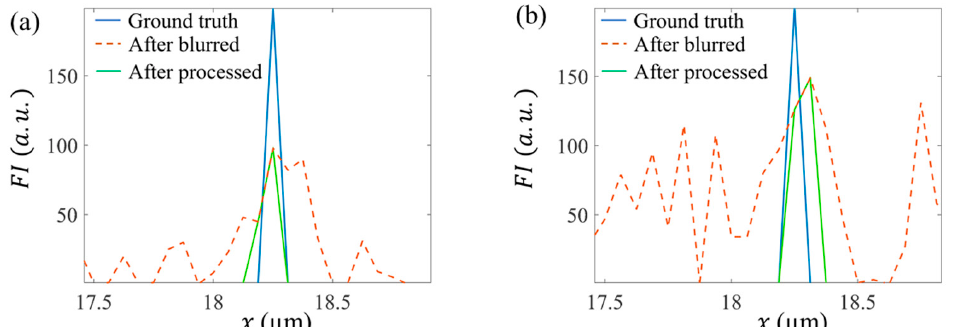
Figure 7. Comparison between the profiles in the ground truth image, blurred and noised image, and DWDC processed images; ( a ) corresponds to Figure 5, and ( b ) corresponds to Figure 6.